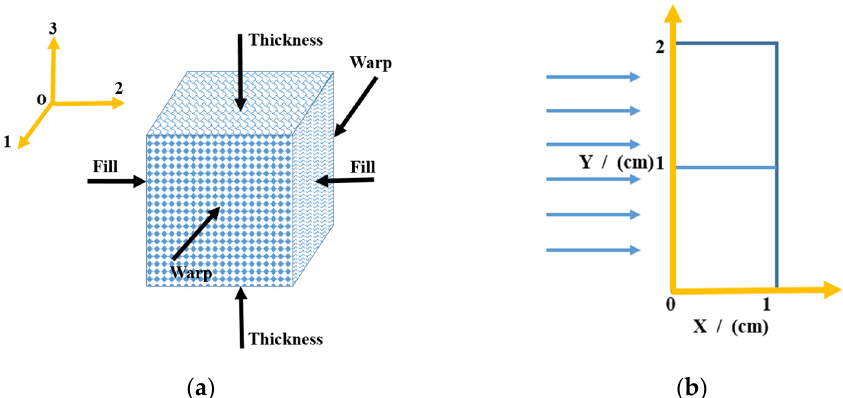
Figure 6. Schematic diagrams of the C/P material model: ( a ) principal directions and lamina of the composite and ( b ) a simplified model for the numerical simulation.